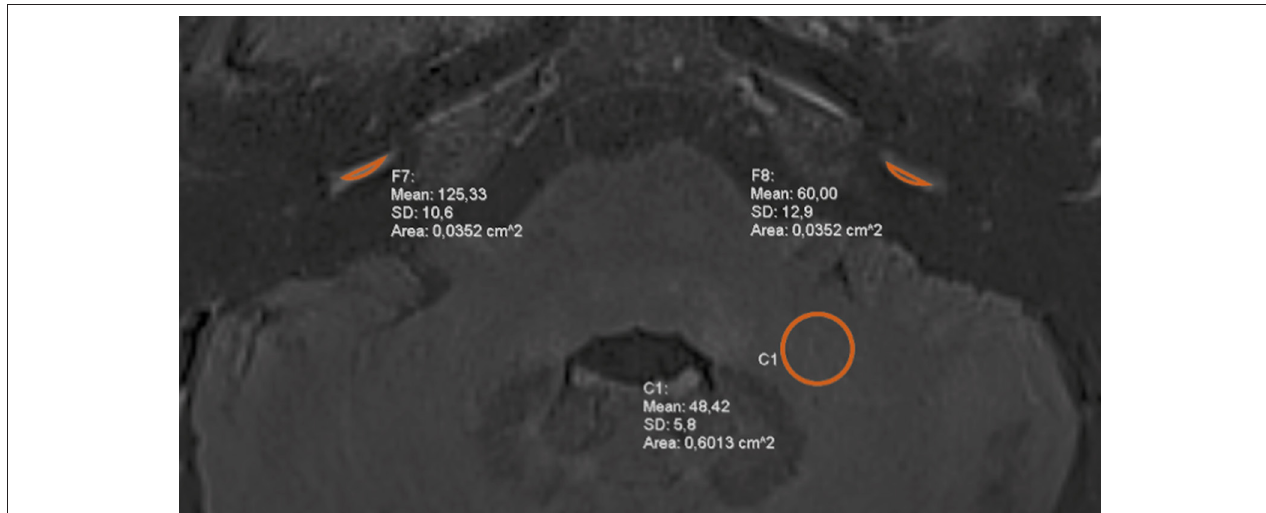
FIGURE 1 | Signal intensity measurements at 4 h-delayed contrast-enhanced 3D FLAIR MRI. Symmetrical regions of interest (ROI) were drawn in the basal cochlear turn of each ear and a circular ROI was placed in the left middle cerebellar peduncle. The measurements were used to calculate the signal intensity ratio (SIR).